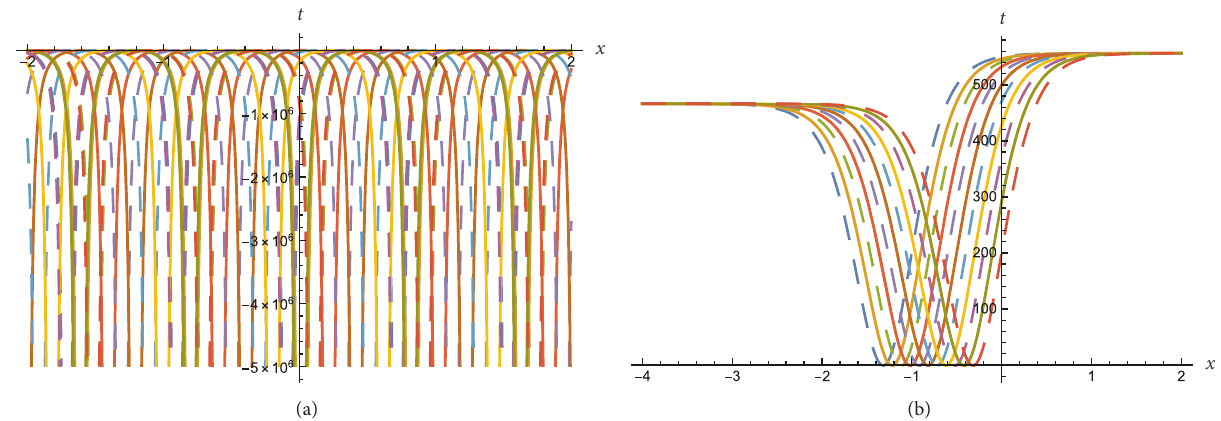
Figure 4: Plot of the exact traveling wave solutions of (a) periodic solitary wave solution (27) with parameters 𝑎 1 = 1; 𝛼 = 0.6;𝑙 0 = 0.7;𝑙 4 = 9;𝑙 = 30;𝜅 = −0.7;𝑐 = 0.1;𝑦 = 0.8 ; (b) dark solitary wave solution (29) plotted at 𝑎 2 0.1; 𝑦 = 0.8 .